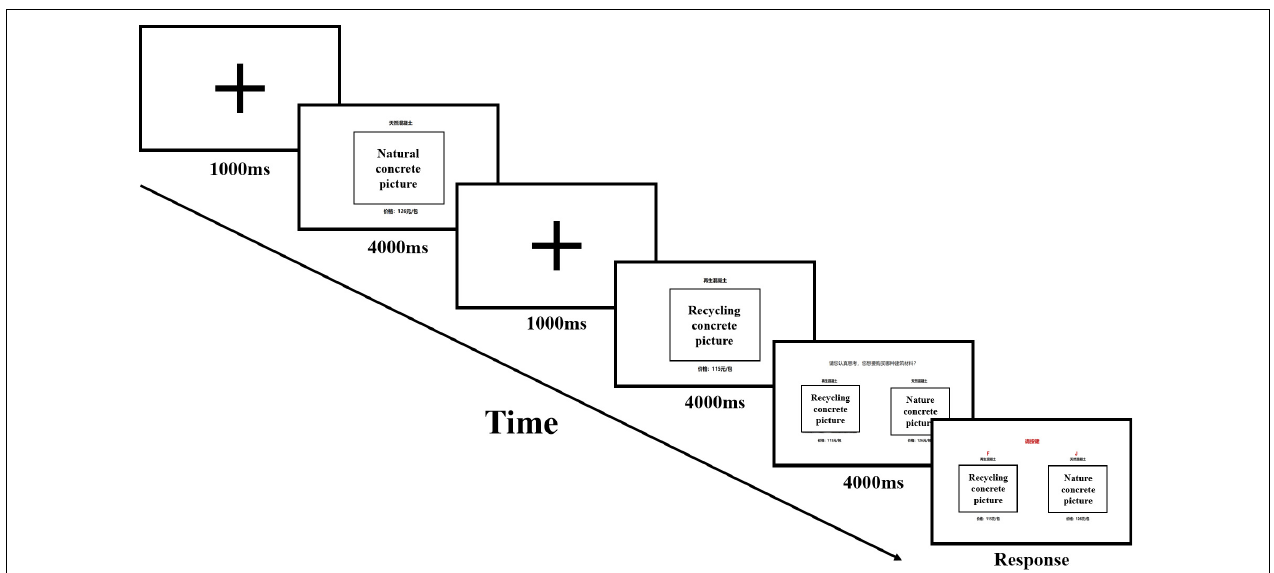
FIGURE 2 | Experimental procedures.